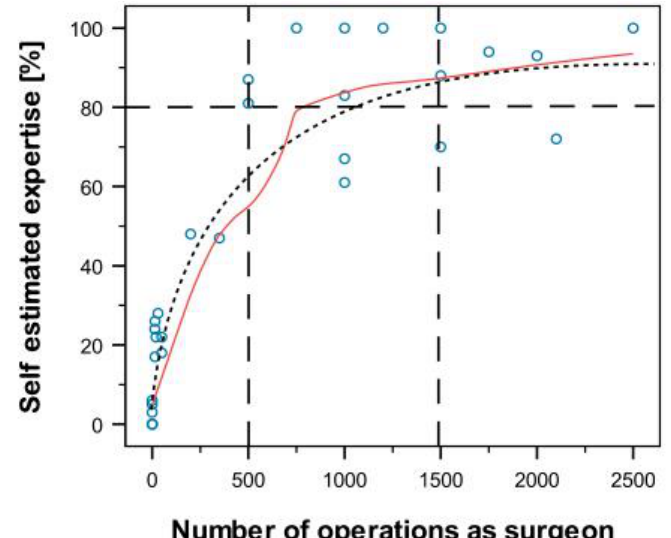
Figure 9. Correlation between self-estimated expertise as a surgeon and the number of minimally invasive operations performed as a surgeon. Due to a nonlinear correlation, a Loess fitting curve (85% of the values) was calculated. This curve approximates a logarithmic curve (see curved dotted line). If this curve is used as a basis and interindividual scattering is suspected, a range of 500–1500 (see vertical broken lines) operations may be used as a prerequisite for an expert (limit 80%, see horizontal broken line).